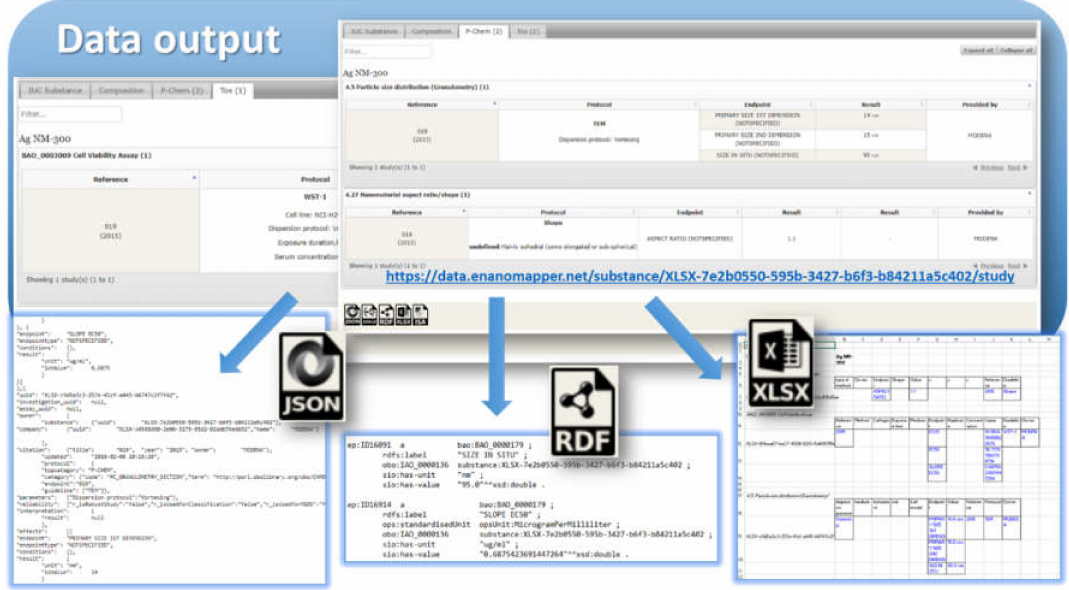
Figure 14. eNanoMapper database export: serialization as JSON, RDF, and Excel /